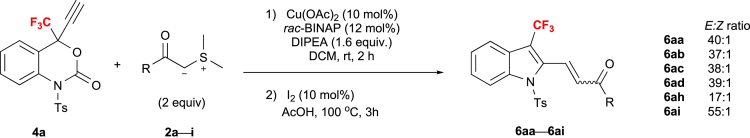
Single Step Formation of 6aa-6ai into Predominantly the E Isomer